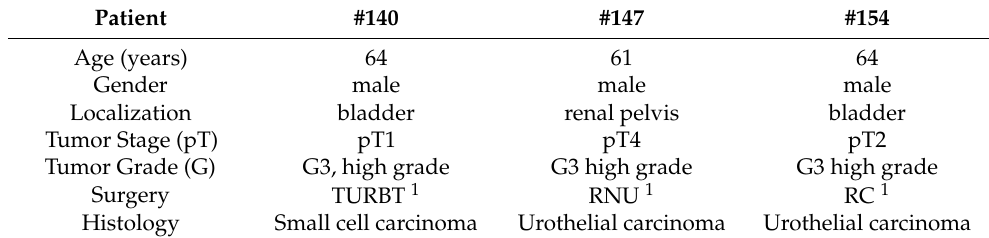
Table 1. Information on tumor samples included.